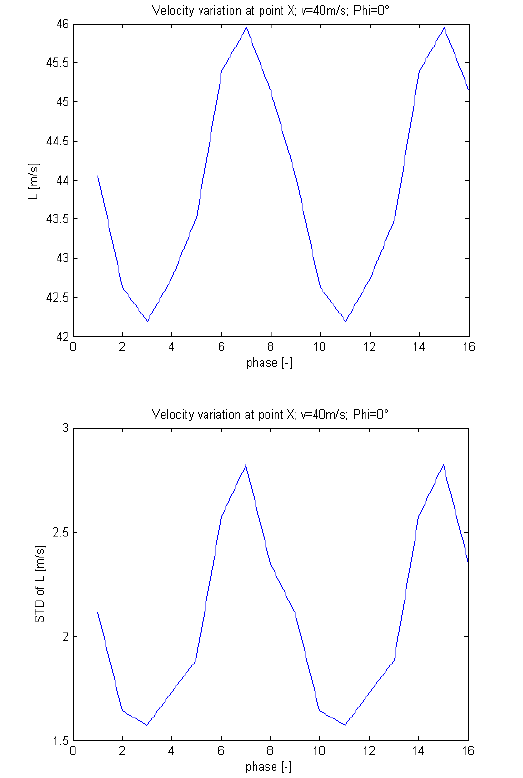
Fig. 12c, d. Phase-locked measurement – mean-phase velocity and STD value - at point